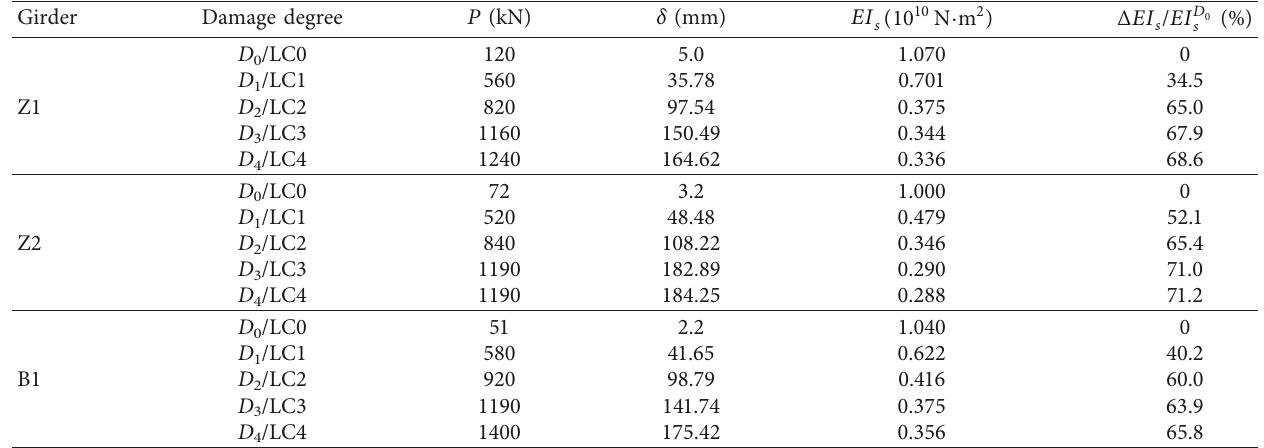
Table 7: Equivalent flexural rigidity of the test girders under different damage conditions. Girder